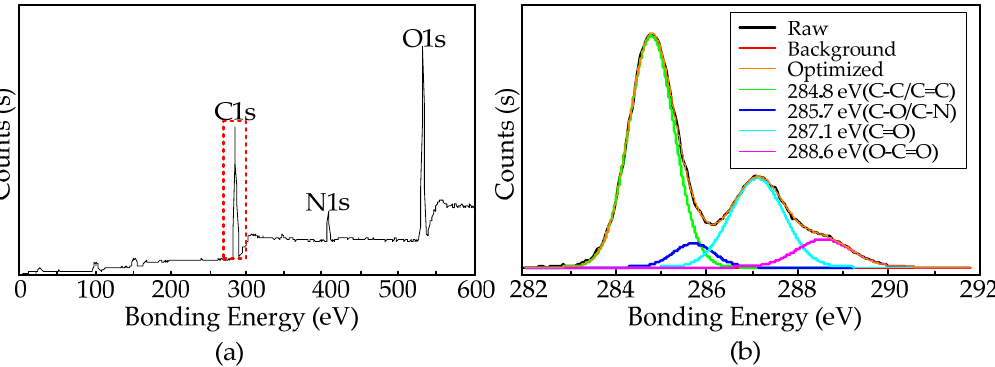
Figure 7. XPS and Raman spectra of CNTs prepared at 800 ◦ C. ( a ): the global spectra; ( b ): the magnification view of C1s .